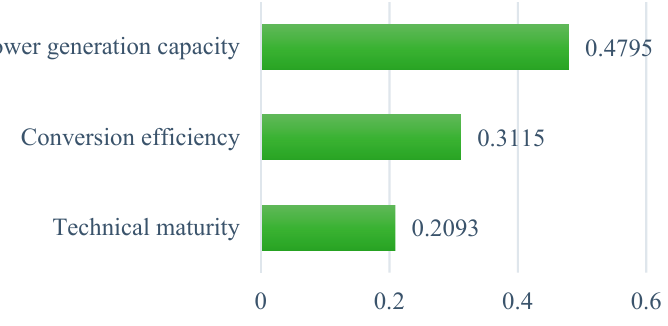
Figure 7. Priority weights of technical sub-criteria.